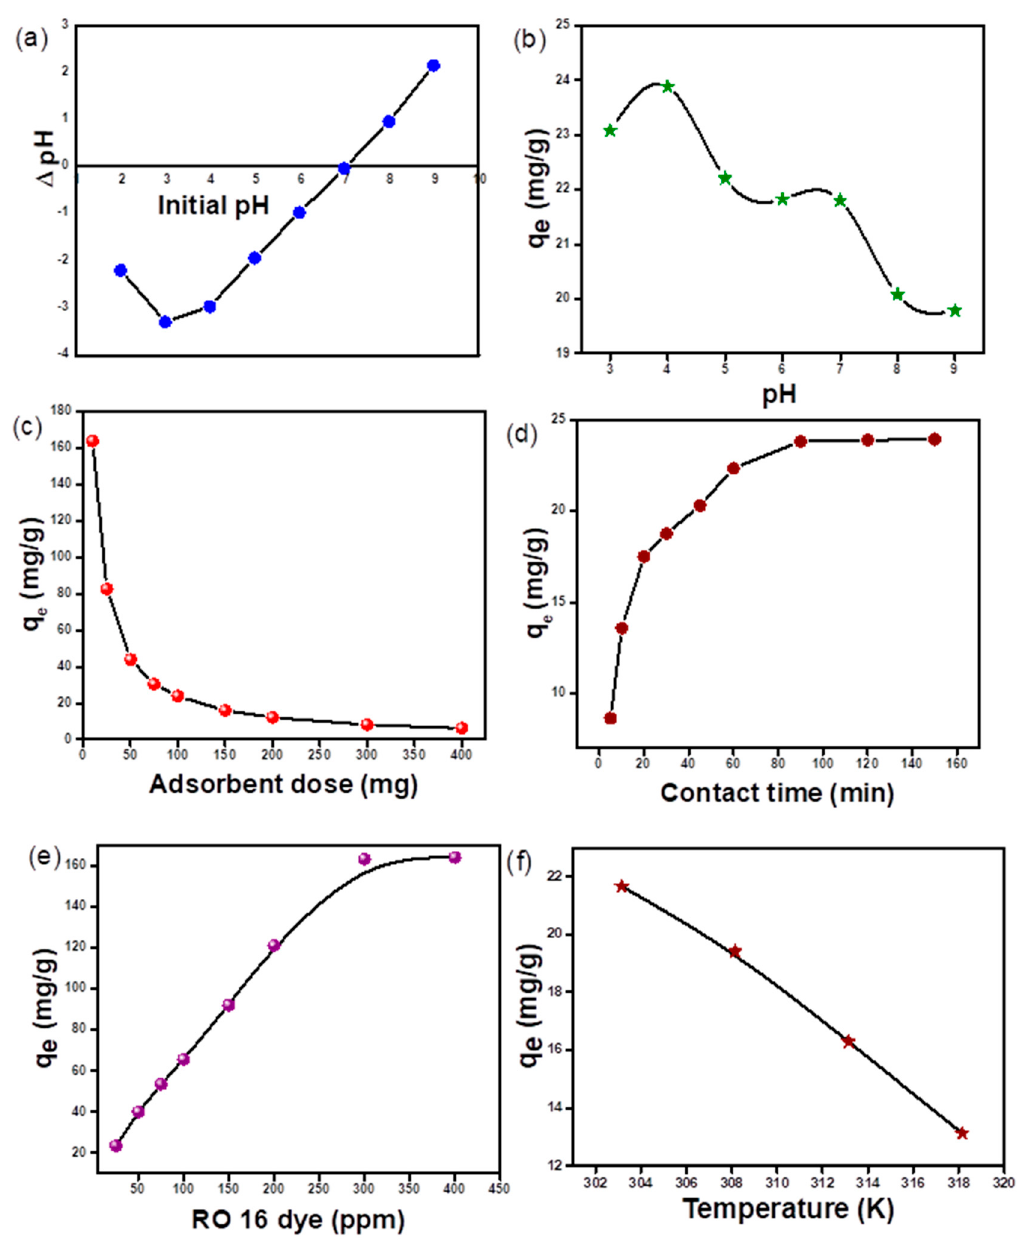
Figure 8. ( a ) pH PZC for m-CGPA, ( b ) influence of RO 16 dye pH ( c ) influence of m-CGPA dose ( d ) influence of contact time on RO 16 dye adsorption ( e ) influence of initial concentration of RO 16 dye ( f ) influence of temperature on RO 16 dye adsorption.